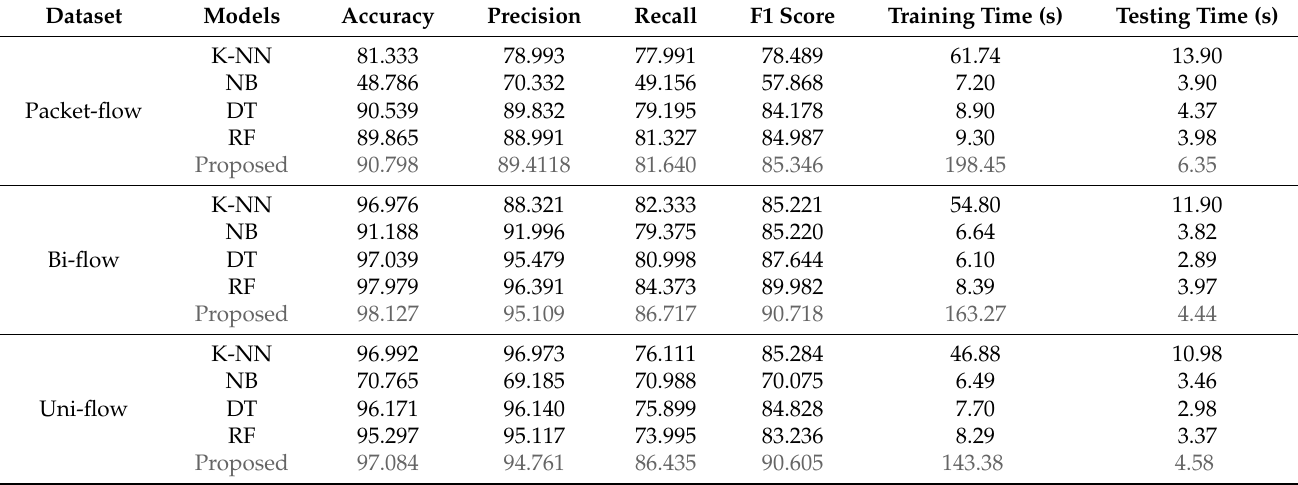
Table 18. Performance comparison of proposed DL-based IDS with other ML algorithm-based IDSs (multi-class classification). Dataset